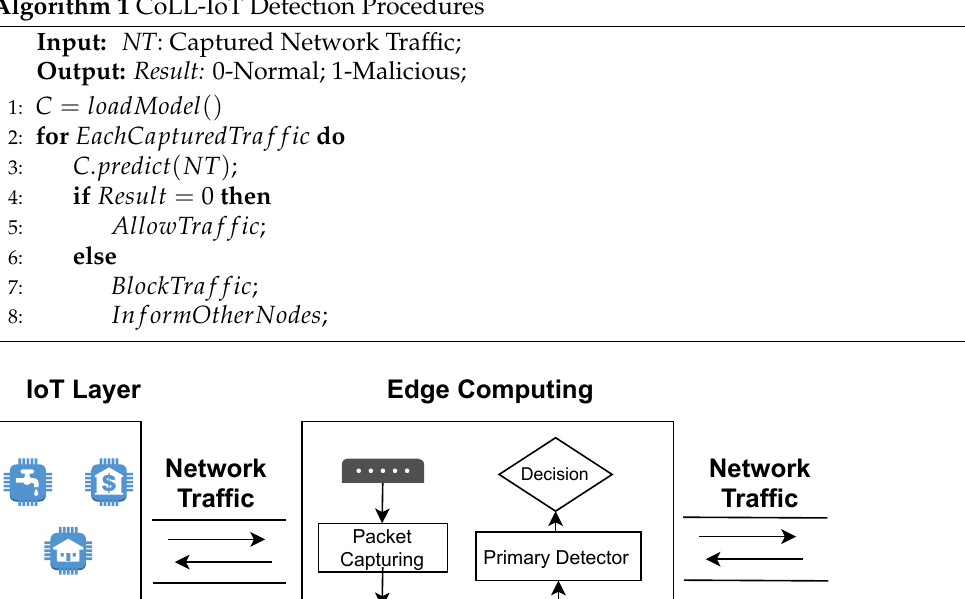
Algorithm 1 CoLL-IoT Detection Procedures